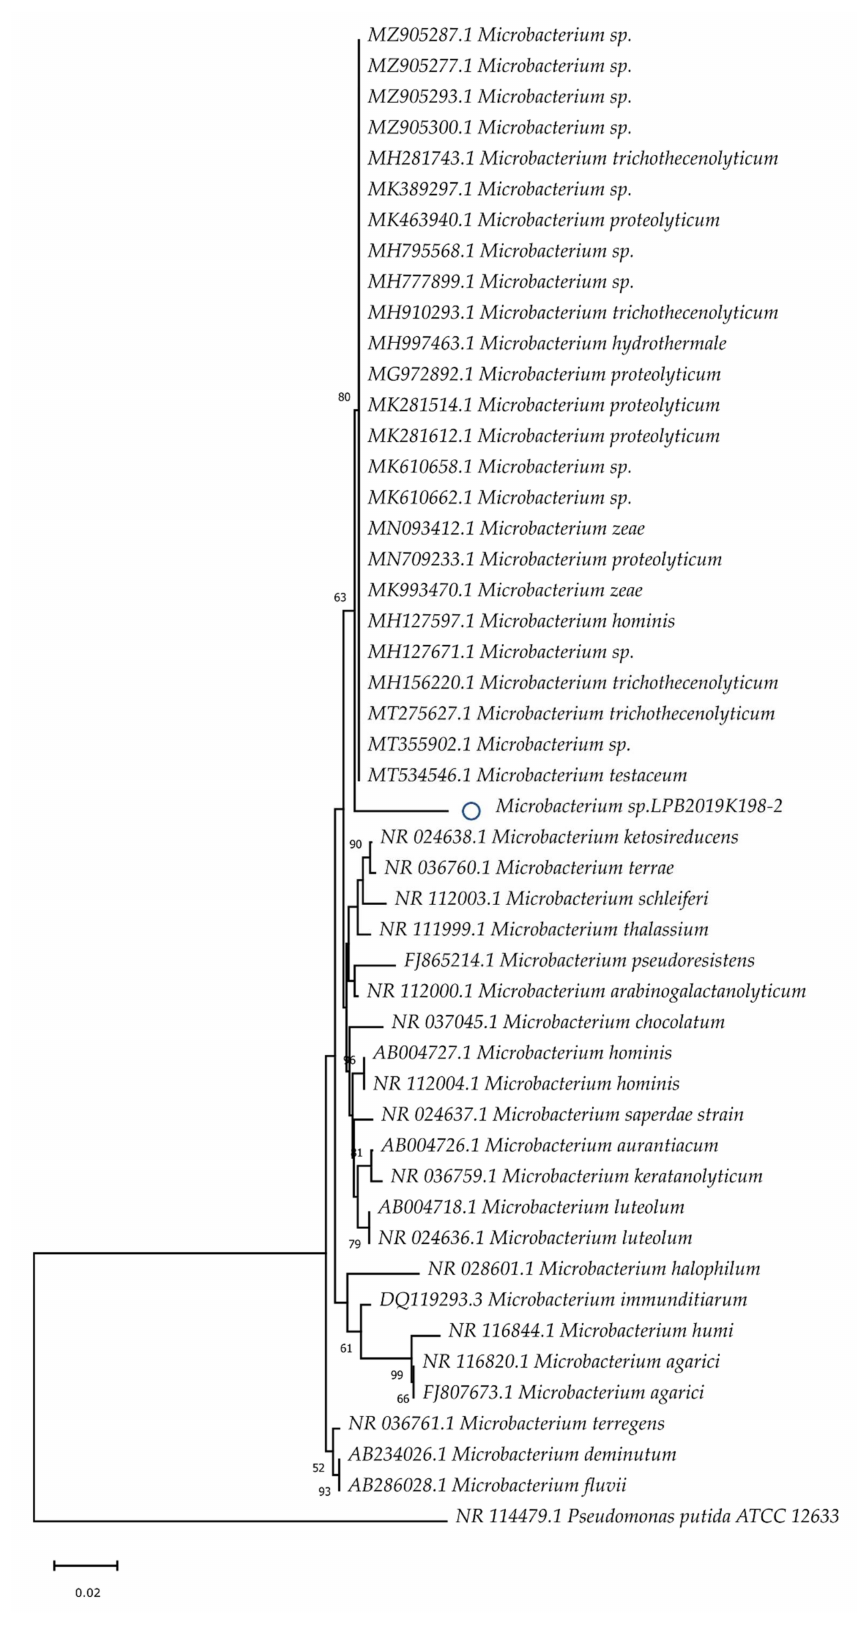
Figure 1. Evolutionary relationships of the Baikal strain of Microbacterium sp. The phylogenetic tree was constructed using the Neighbor-Joining method. The Baikal strain is marked with the “o”